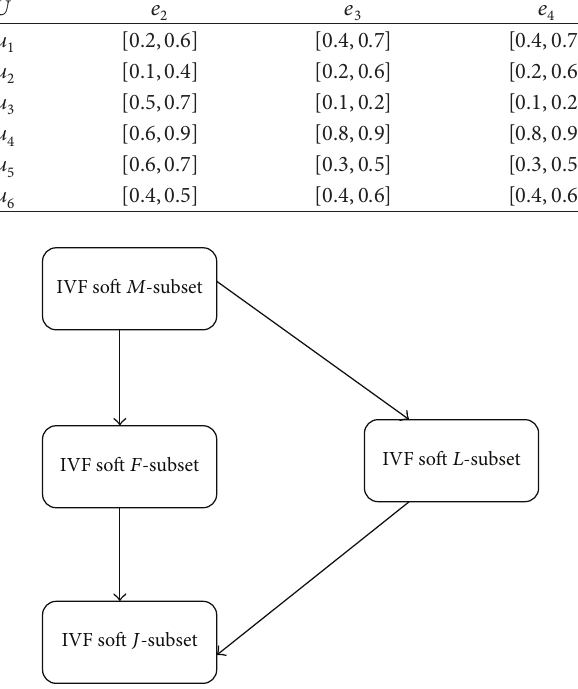
Figure 1: Relations among different types of IVF soft